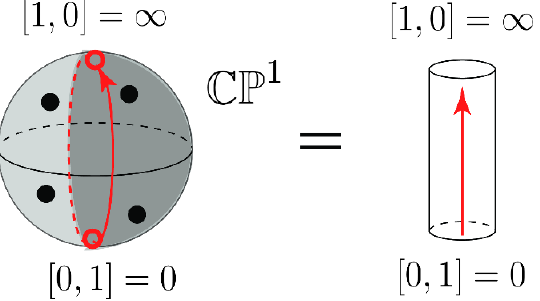
Figure 4 . A fractional instanton for CP 1 -model interpolates between two di(cid:11)erent vacua, 0 and 1 (the black dots represents singular points, as discussed in (cid:12)gure 2). In cylindrical coordinate (so that the geometry is R (cid:2) S 1 ) with (cid:12)xed x , this moves along the R -direction from past to future in(cid:12)nities, as we vary the parameter t . The full trajectory, with both t and x varied, is a hemisphere, and when the two such hemispheres are combined we obtain a full sphere. This is a manifestation of the fact that two fractional instantons combine into a single instanton.